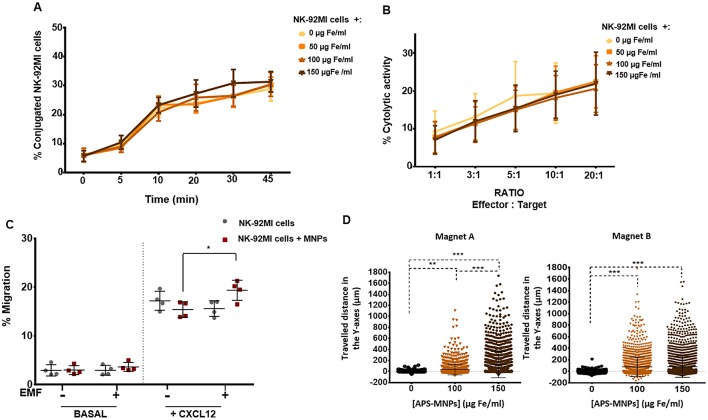
Functional assessment of NK-92MI cells after their association with MNPs and in vitro magnetic retention. (A) Conjugation kinetics of NK-92MI cells, after being treated with MNPs, with the K562 cell line, co-incubated in a 1:2 ratio. (B) Cytolytic activity of NK-92MI cells, after treatment with different concentrations of MNPs, against the K562 cell line, co-incubated in different ratios for 4 h. (C) Migratory capacity of NK-92MI cells after treatment with MNPs in response to a specific chemotactic gradient and in the presence or absence of an EMF in the same direction. The results were normalized against a control well (in the absence of a transwell assay). (D) Displacement of NK-92MI cells in the direction of the magnetic gradient (Y axis) after being treated or not with MNPs and exposed to different EMFs. Cell displacement was quantified by analyzing at least 100 cells per video using Imaris software. The results shown (mean ± SD) are representative of three or four independent experiments, *p < 0.05, **p < 0.01, ***p < 0.001.